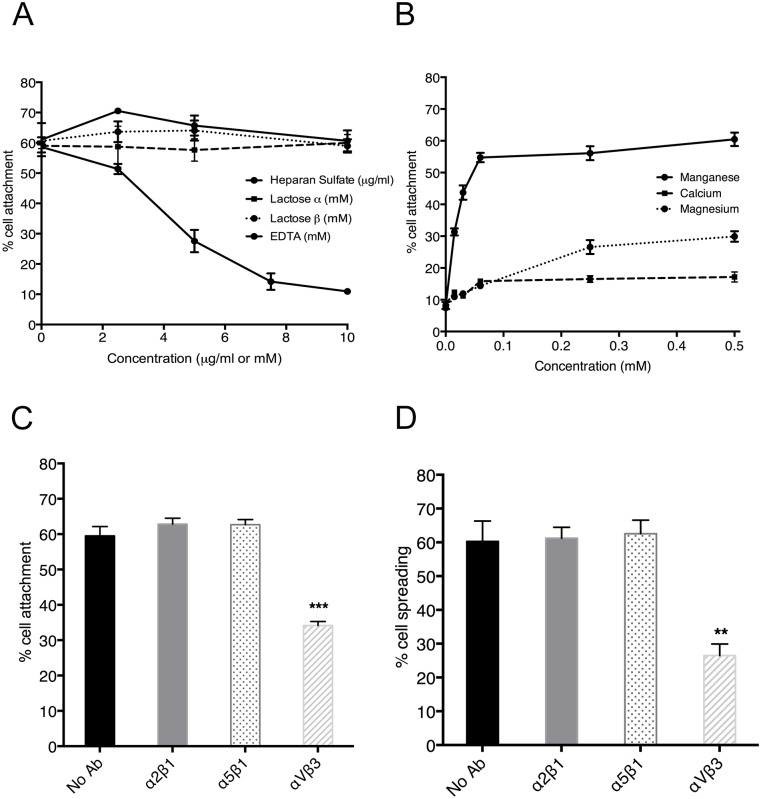
Mechanism of EPC attachment to rhTE.(A) EPCs attached to 40 μg/ml rhTE in the presence of α-lactose, β-lactose, heparan sulfate, or EDTA. (B) Attachment of EPCs to 40 μg/ml rhTE in the presence of Ca2+, Mg2+, or Mn2+. (C) and (D) Inhibition of EPC attachment and spreading on 40 μg/ml rhTE using antibodies to integrins α2β1, α5β1, and αvβ3. Error bars represent S.E.M. of triplicate measurements.